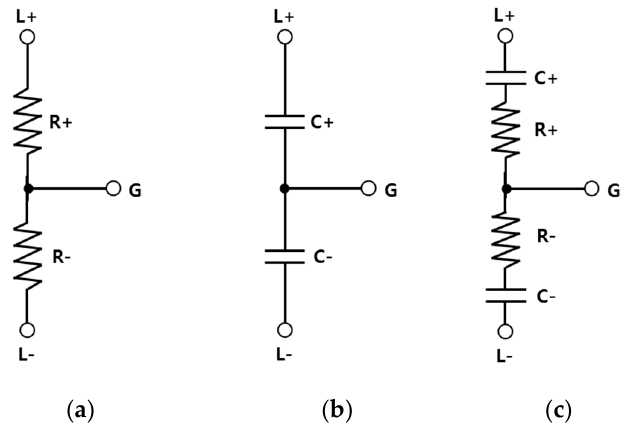
Figure 7. Types of mid ‐ point grounding systems: ( a ) Mid ‐ point ground system with two resistors; ( b ) Mid ‐ point ground system with two capacitors; ( c ) Mid ‐ point ground system with two resistors and capacitors.